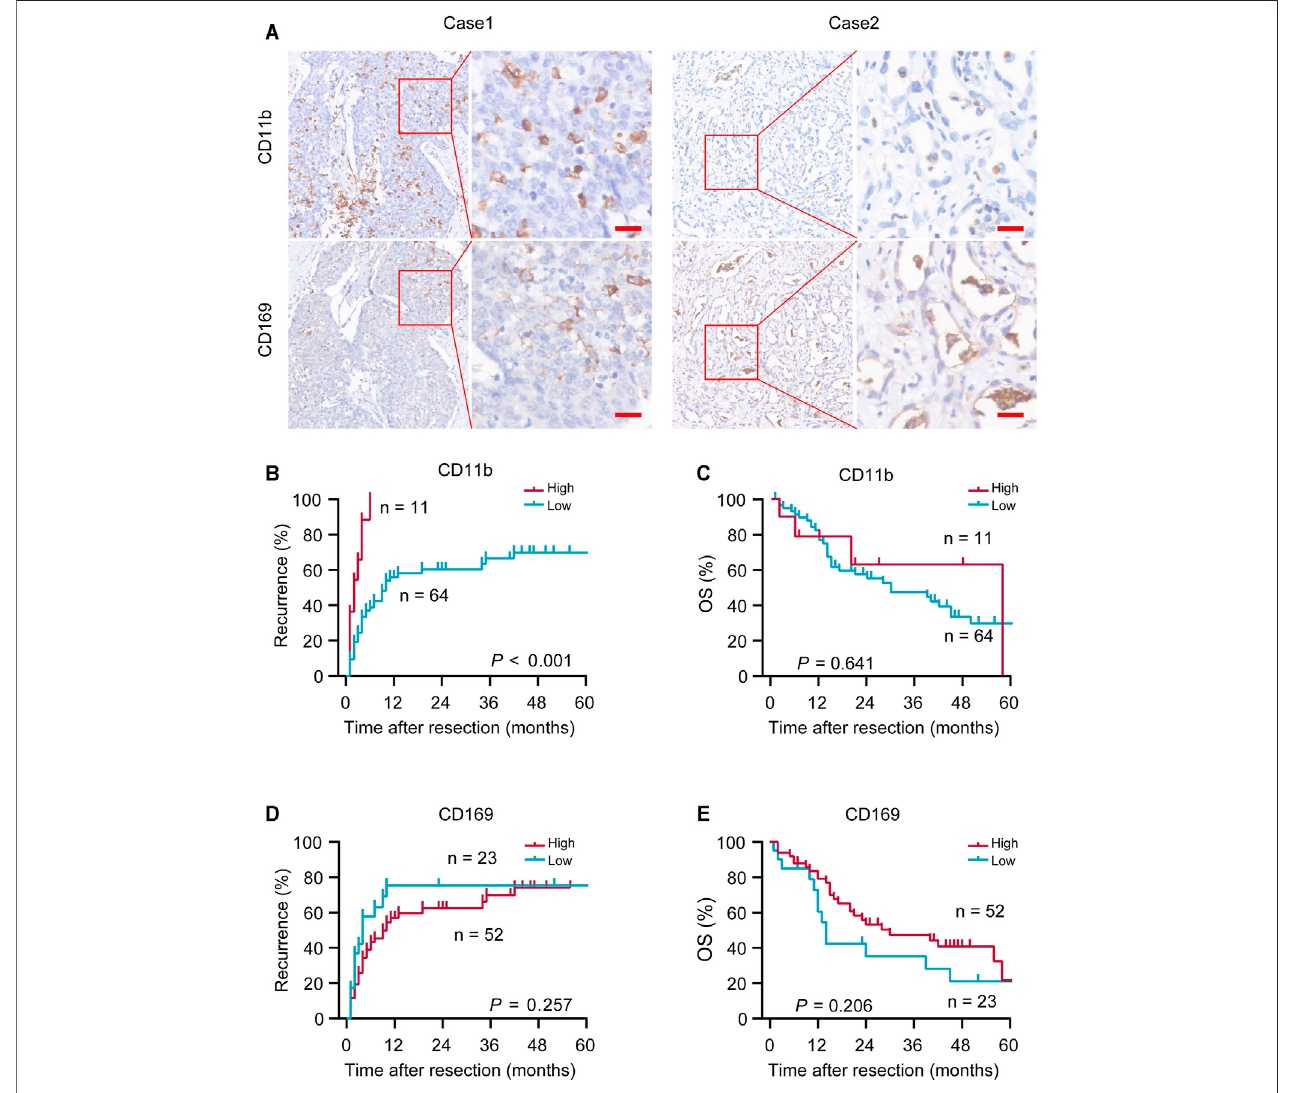
FIGURE1| Representativeimmunohistochemical(IHC) images and prognostic valuesofCD11b and CD169. (A) Representative in situ IHC imagesofCD11b and CD169 in intrahepatic cholangiocarcinoma (iCCA) after surgery. (B – E) Kaplan – Meier survival estimates of the recurrence and overall survival (OS) were performed according to the expression of CD11b and CD169 in iCCA. Scale bar, 20 μ m; p values were calculated by log-rank.